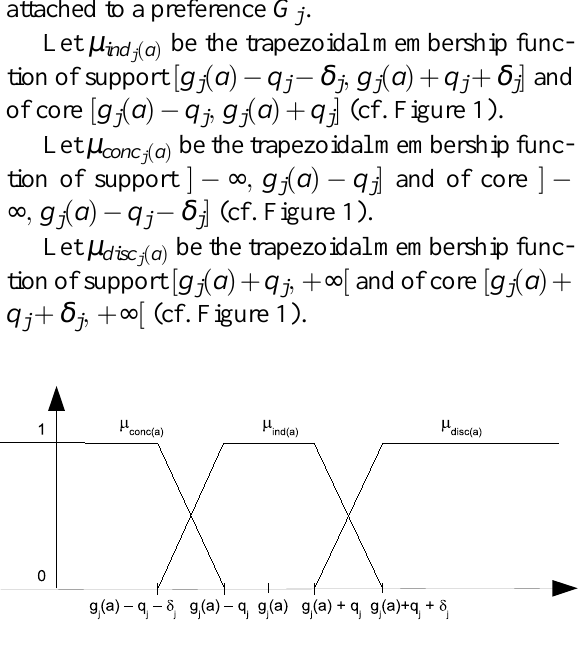
Fig. 1. Concordance, indifference,